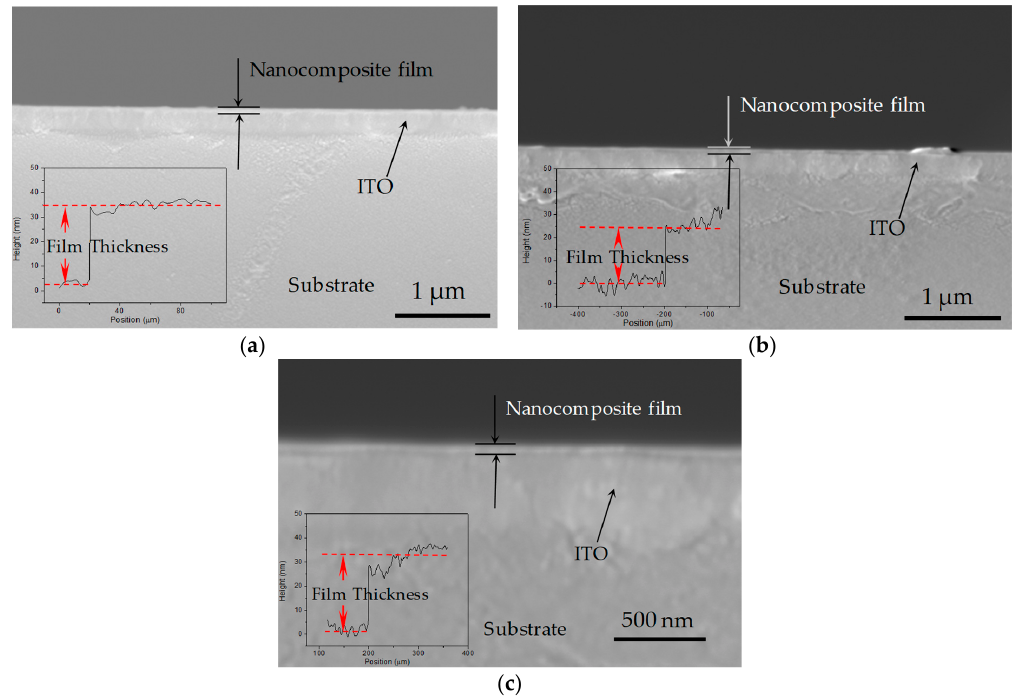
Figure 2. Scanning electron microscope (SEM) images of cross ‐ sectional characterization and film thickness by Profilometer for PBD:GO nanocomposite films with the chemical component of weight ratio ( a ) 2:1, ( b ) 5:1, and ( c ) 10:1. Indium tin oxide, ITO. ratio ( a ) 2:1, ( b ) 5:1, and ( c ) 10:1. Indium tin oxide,